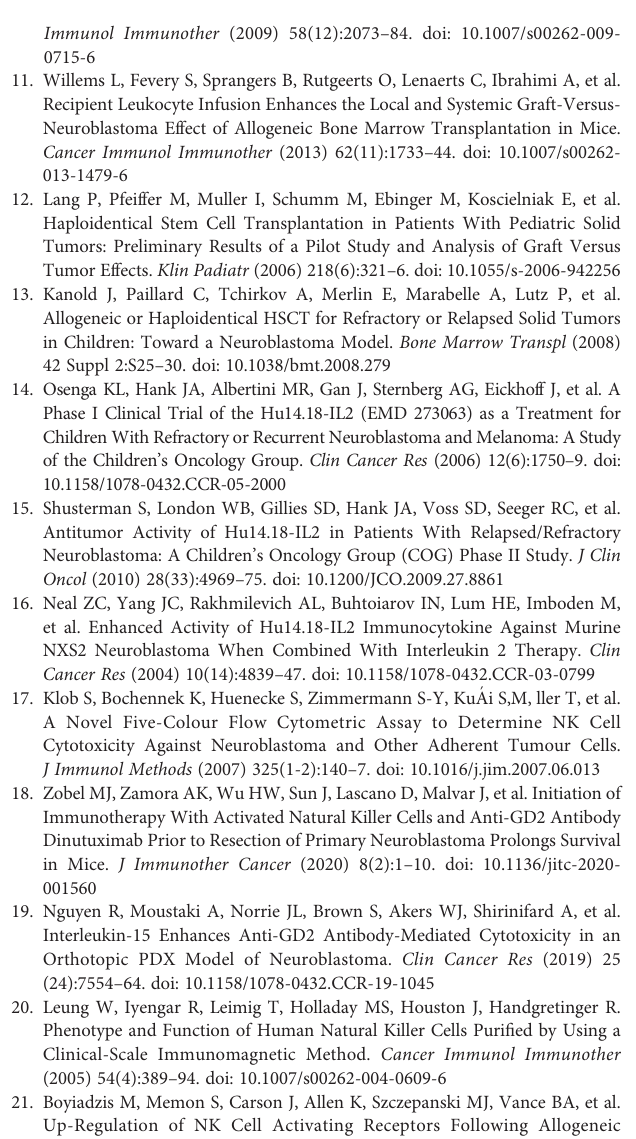
Supplementary Figure 1 | Comparison of GD2 expression on murine NBL and syngeneic versus allogeneic HSCT on NBL tumor growth. (A) Flow cytometric expressionofGD2onmurineNBLcelllines. (B) A/Jmicewerelethallyirradiatedand transplanted with 5 x106 B6 BM cells and 2.5 x103 B6 T cells (allogeneic BMT) or 5 x10 6 A/J BM cells and 2.5 x10 3 A/J T cells (syngeneic BMT) on Day +0. On Day +10, mice were inoculated subcutaneously with 2 x 10 6 NXS neuroblastoma cells. Mice were followed for tumor growth. N = 5 mice/group. *p < 0.05. Supplementary Figure 2 | In vivo potency of ex vivo activated NK cells. Balb/c mice werelethallyirradiatedandtransplantedwith5x10 6 CB6F1BMcells(allogeneicHSCT)onDay +0aswellas2.5x10 6 A20lymphomacellsonDay+5.ThenPBS(NoNKs)or6x10 6 CB6F1 IL15/IL15R a activated or CD137L/IL15/IL15R a activated NK cells were given on Day +13. All mice were followed for survival. N=5 mice/group. *p < 0.05 as compared to No NKs group. Supplementary Figure 3 | Ly49 NK subset analysis. (A) Sample gating strategy for analyzing Ly49C/I+NK1.1+ cells pre- and post-expansion by CD137L/IL15/ IL15R a aAPCs at a 1:1 ratio for 1 week. (B) Flow cytometric analysis of Ly49H- and Ly49H+ NK cell subsets for cytotoxicity markers (TRAIL, FasL and CD107a) and cytokine production (TNF a ) from a single expansion.